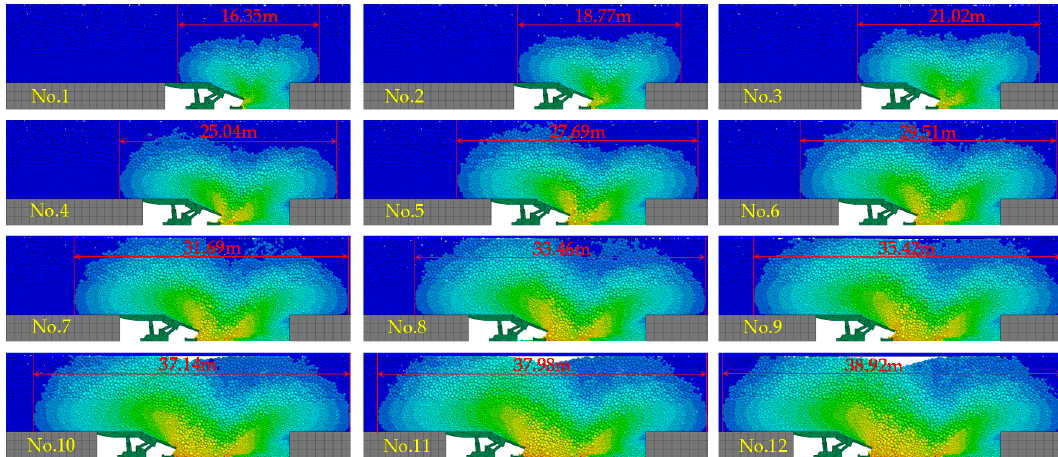
Figure 8. The evolutional process of LB.